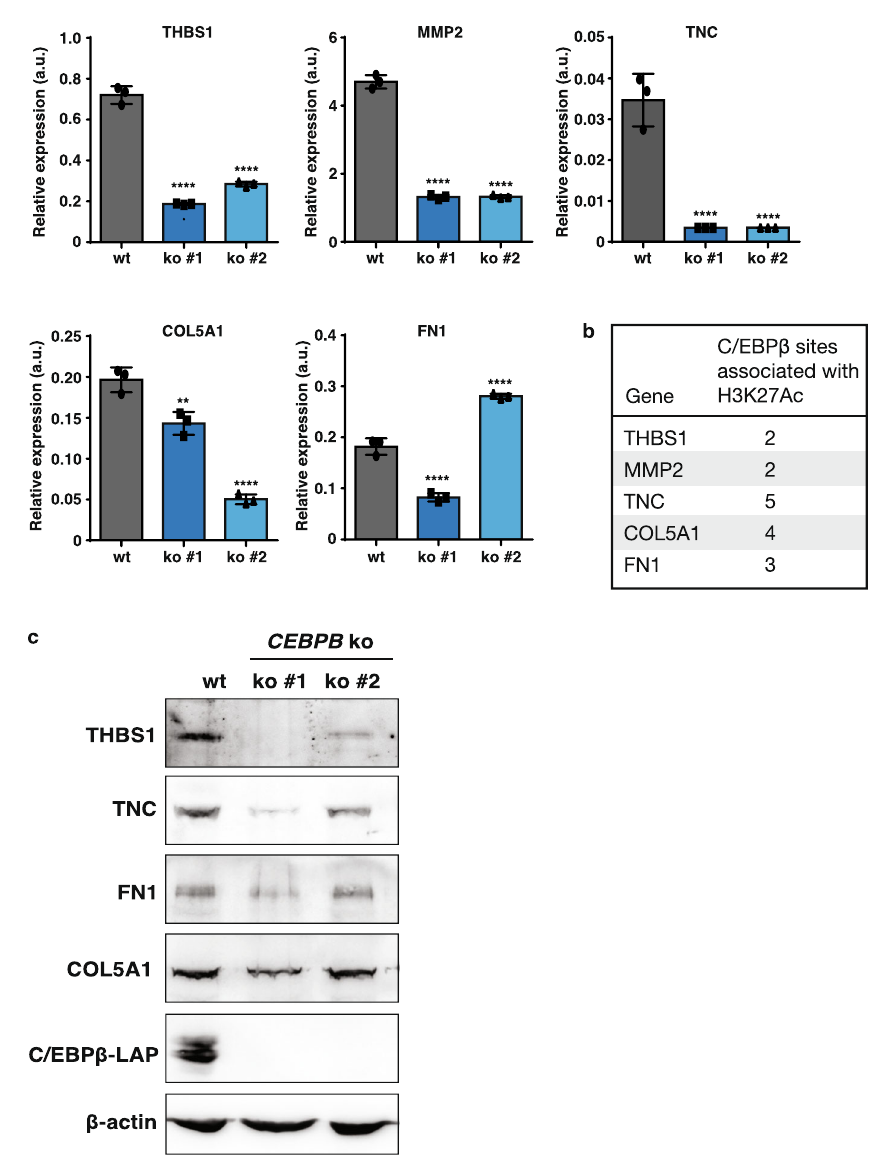
Fig. 6 Downregulation of ECM factors in CEBPB -ko cells. a Expression of ECM-associated genes relative to GAPDH in wt BT-20 cells and two different clones of CEBPB -ko BT-20 cells ( n = 3). Results are analysed using one-way ANOVA analysis. Error bars represent SD, ** p < 0.01, **** p < 0.0001. b C/EBP β -associated fragments associated with H3K acetylation (H3K27Ac). Data from the ENCODE database (http://genome.ucsc.edu/ ENCODE/)(see Supplementary Table 1). c Immunoblots showing expression of Thrombospondin 1 (THBS1), Tenascin C (TNC), Fibronectin 1 (FN1) or Collagen 5A1 (COL5A1) in wt BT-20 cells and two different clones of Cebpb -ko BT-20 cells. Loss of C/EBP β -LAP expression shows the successful CEBPB -knockout and β -actin was used for loading